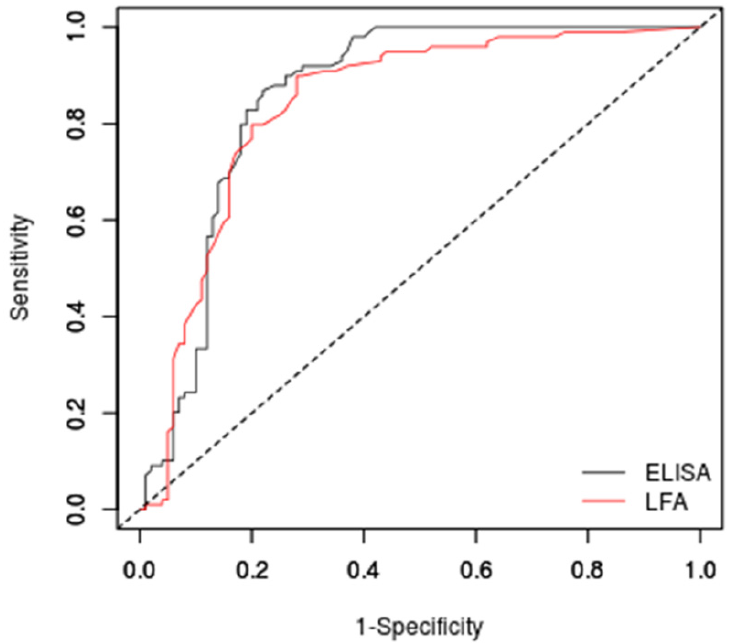
Figure 6. Receiver operator characteristic curves of the two commercial tests evaluated in this study. ELISA = Bio-Rad Platelia sandwich ELISA; LFA = IMMY s¯ona AGM lateral flow